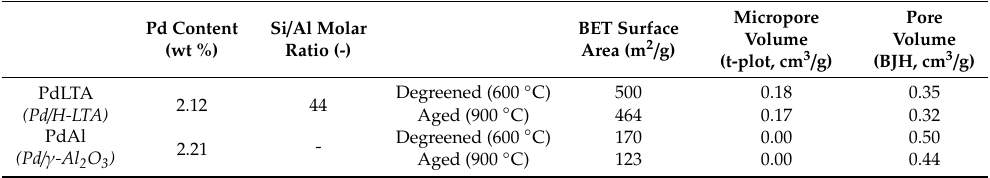
Table 1. Pd content and Si / Al molar ratio measured by ICP-SFMS together with BET surface area, t-plot micropore volume and BJH pore volume of degreened and 900 ◦ C aged samples